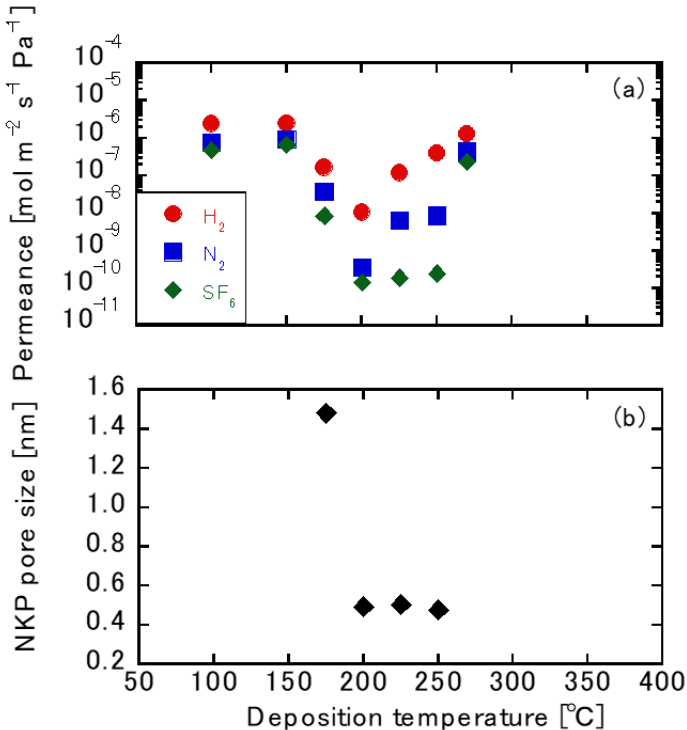
Figure 5. ( a ) The single gas permeation dependence on deposition temperature and ( b ) the normalized Knudsen-based permeance (NKP) pore size dependence on deposition